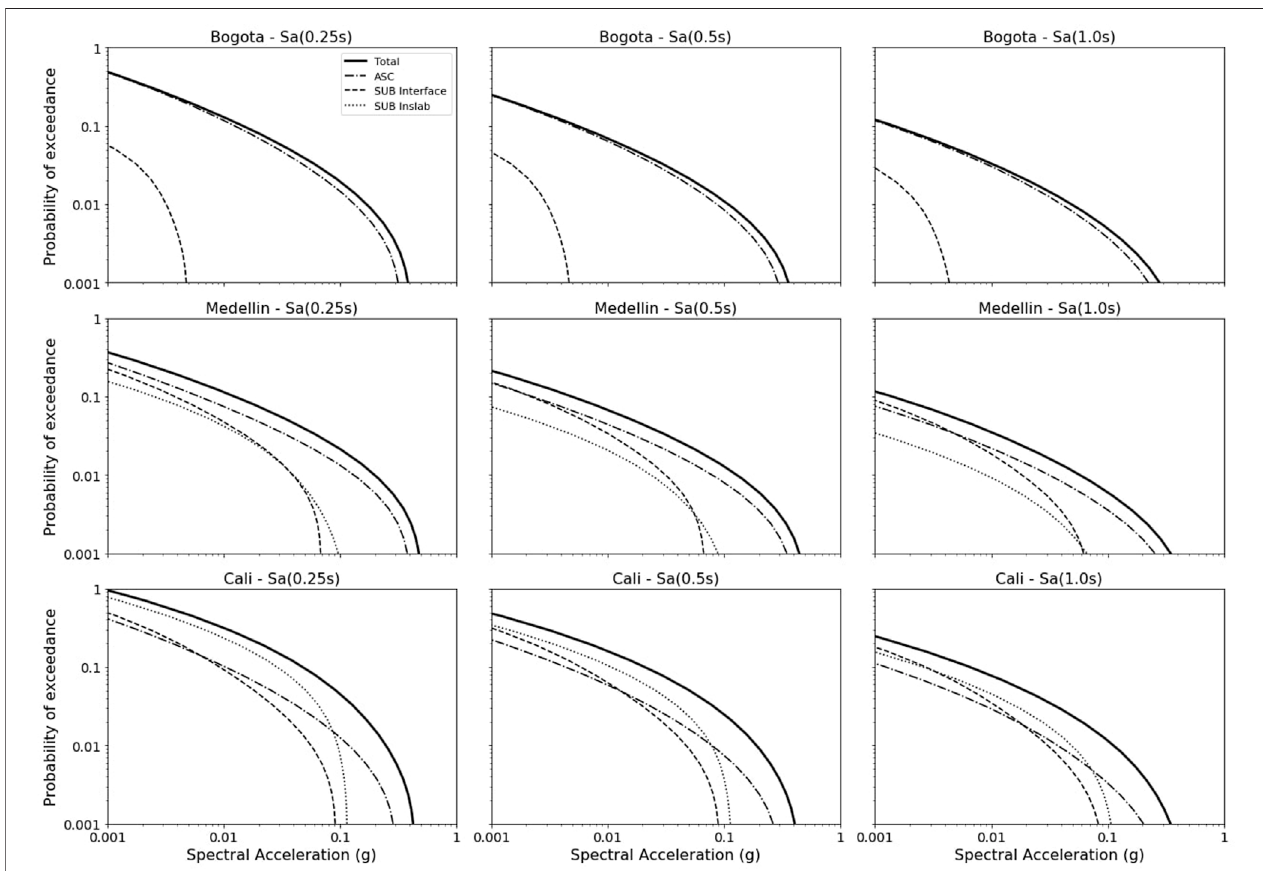
FIGURE 4 | Uniform hazard spectra for 10% probability of exceedance (poe) for Sa (0.25 s) left, Sa (0.5 s) center, and Sa (1.0 s) right for the three cities: Bogotá (top), Medellín (center), and Cali (bottom).